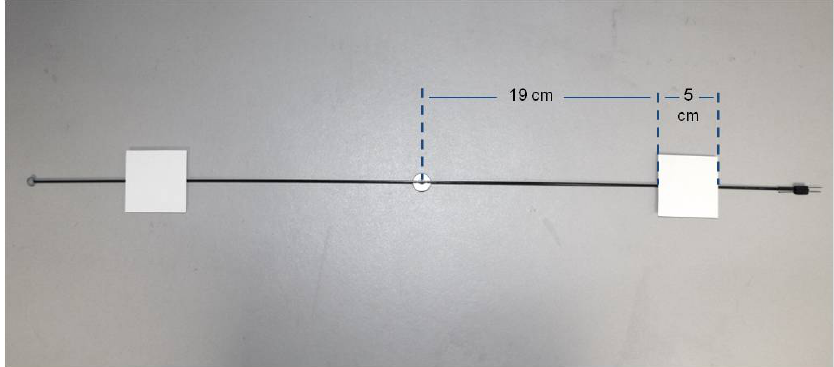
Figure 4. Detail of card stock, counterweight, and insect attachment